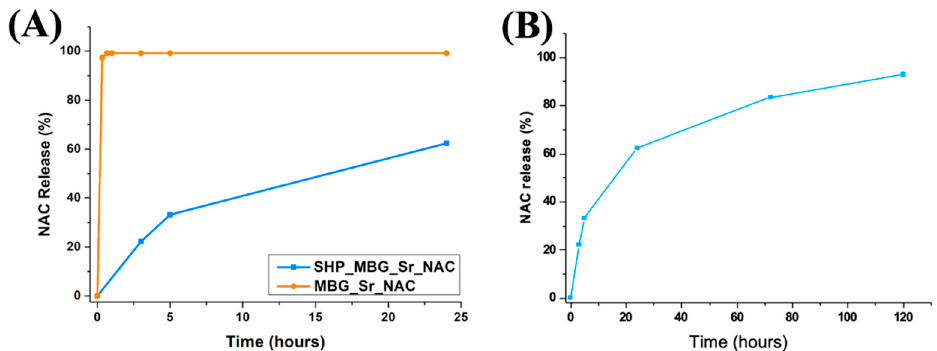
Figure 12. ( A ) Comparison among the NAC release profiles assessed from MBG_Sr_NAC and